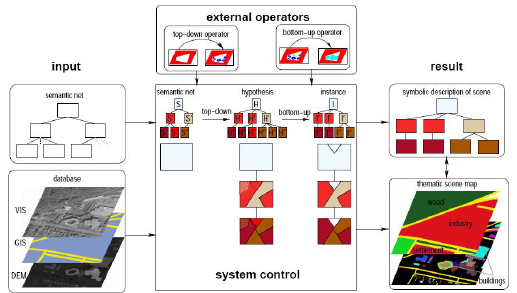
Figure 2- Components of the analysis process.